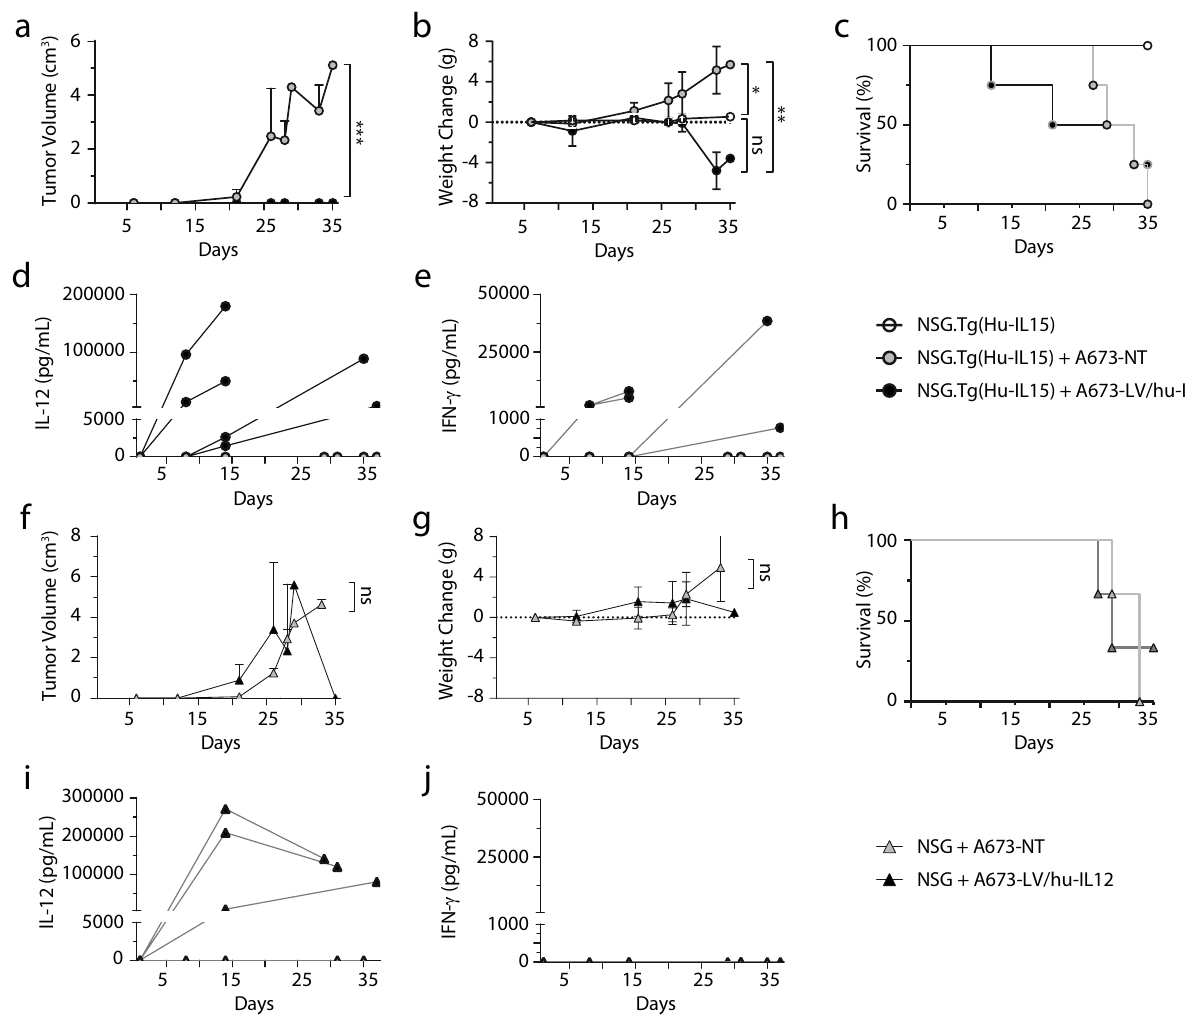
Figure 5. Ewing sarcoma (A673) non-transduced or LV/hu-IL-12 transduced sarcoma line cells were implanted in immunocompromised NSG and NSG-IL-15 transgenic mice with or without humanization. Tumor volumes ( a , f ) and weights ( b , g ) were serially recorded with daily survival/disability ( c , h ) assessments. Serum was collected from peripheral blood prior to injection and weekly until death or at 35 days post tumor injection. Multiplex cytokine analysis performed with display of serum IL-12 ( d , f ) and IFN-γ ( e , j ). N = 3–4, displayed as mean ± standard deviation. * = p < 0.05, ** = p < 0.001, *** = p <